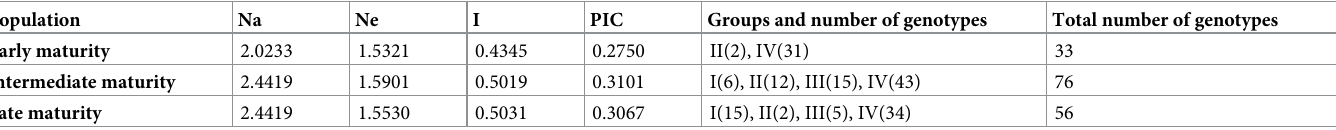
Molecular marker types and population size are the factors that influence the evaluation of genetic diversity and relationships. SSR markers play an important role in establishment of genetic diversity and relationships because they are reproducible, polymorphic, codominant and abundant in plant genomes [35–36]. Forty-three SSR markers produced 111 alleles among the 165 cauliflower inbred lines, and the mean values of the number of alleles (Na), effective number of alleles (Ne), Shannon’s Information index (I), and polymorphism information con- tent (PIC) were 2.581, 1.599, 0.517, and 0.316, respectively (S2 Table). The mean PIC value Table 2. Then number of alleles (Na), effective number of alleles (Ne), Shannon’s Information index (I) and polymorphism information content (PIC) of different maturity populations estimated by 43 SSR markers. Population Na Ne PIC Groups and number of